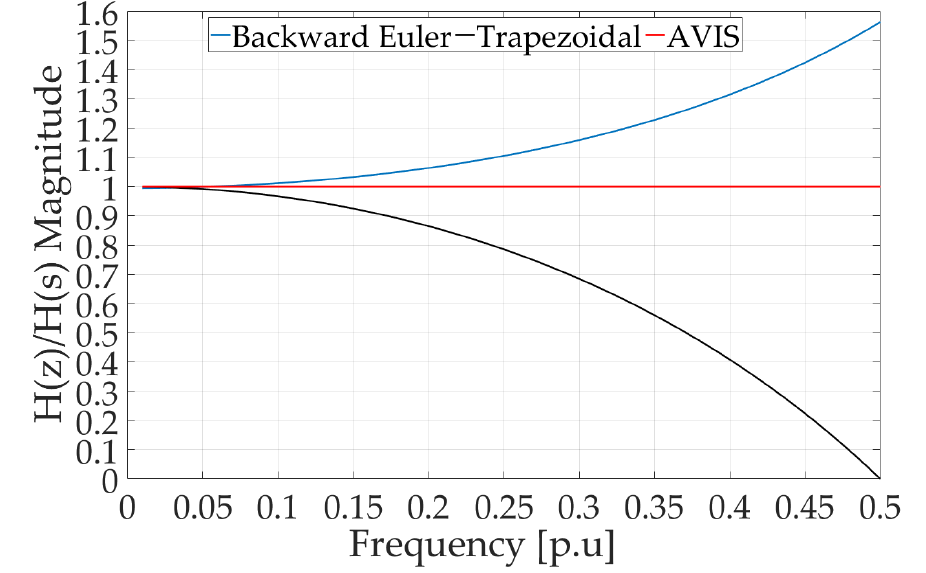
Figure 3. Amplitude frequency response of transmittance for considered numerical methods.